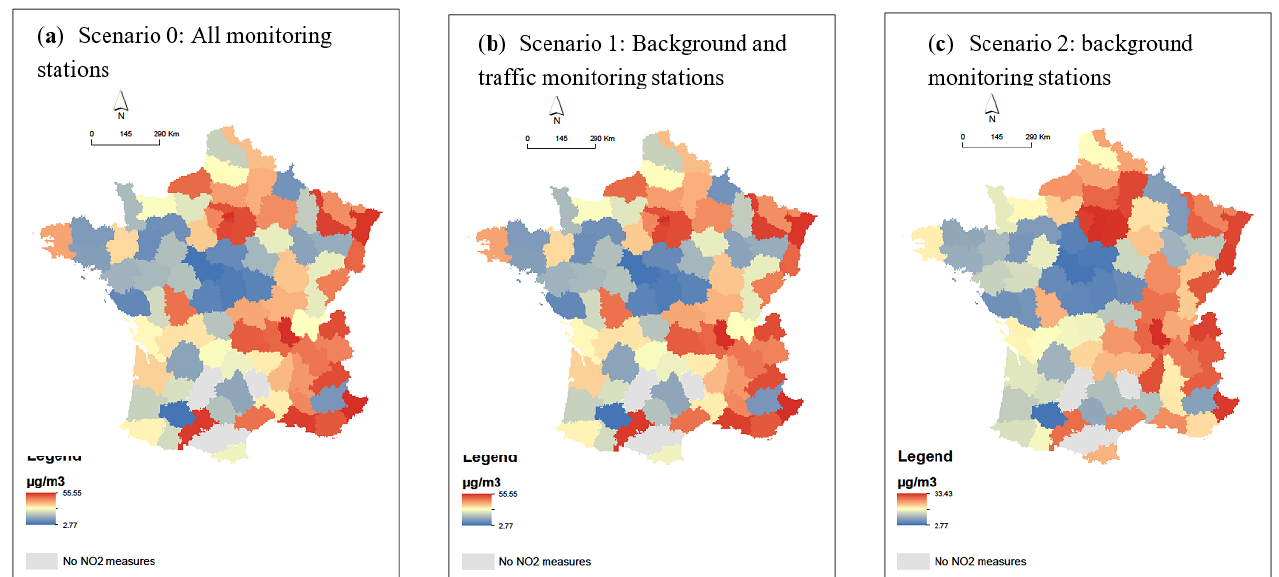
Figure 2. Spatial distribution on the French department scale of the annual mean of NO 2 between 2014 and 2018 ( a ) for all monitoring stations (Scenario 0), ( b ) for background and traffic monitoring stations (Scenario 1), and ( c ) for background monitoring stations only (Scenario 2).